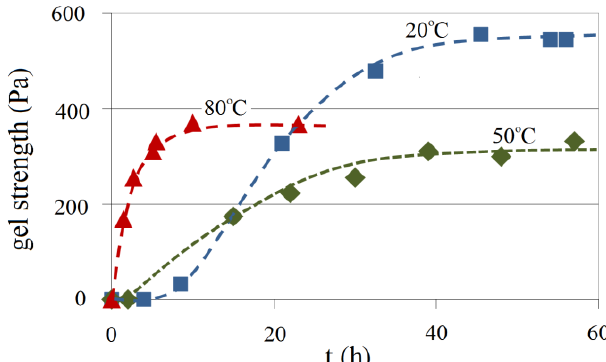
Figure 20. Gel strength development profiles of 4.5 wt% Na-silicate with a pH of 10.30 vs. aging time at temperatures of 20, 50 and 80 °C.